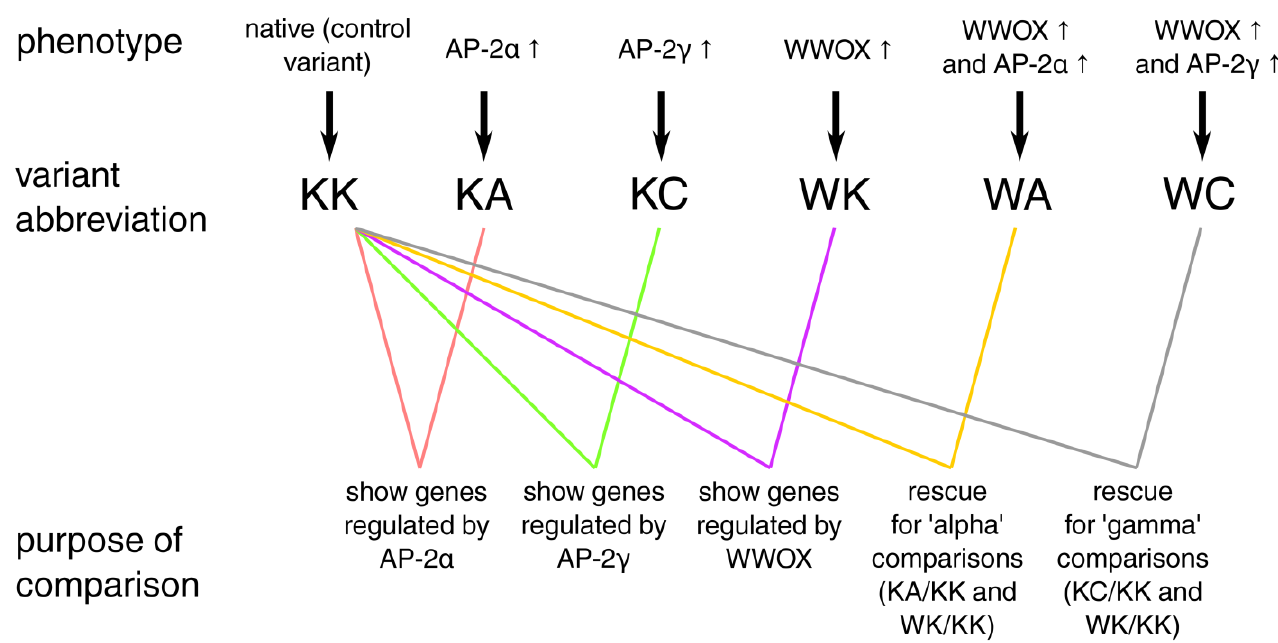
Figure 1. Comparisons of cellular variants and their purpose.